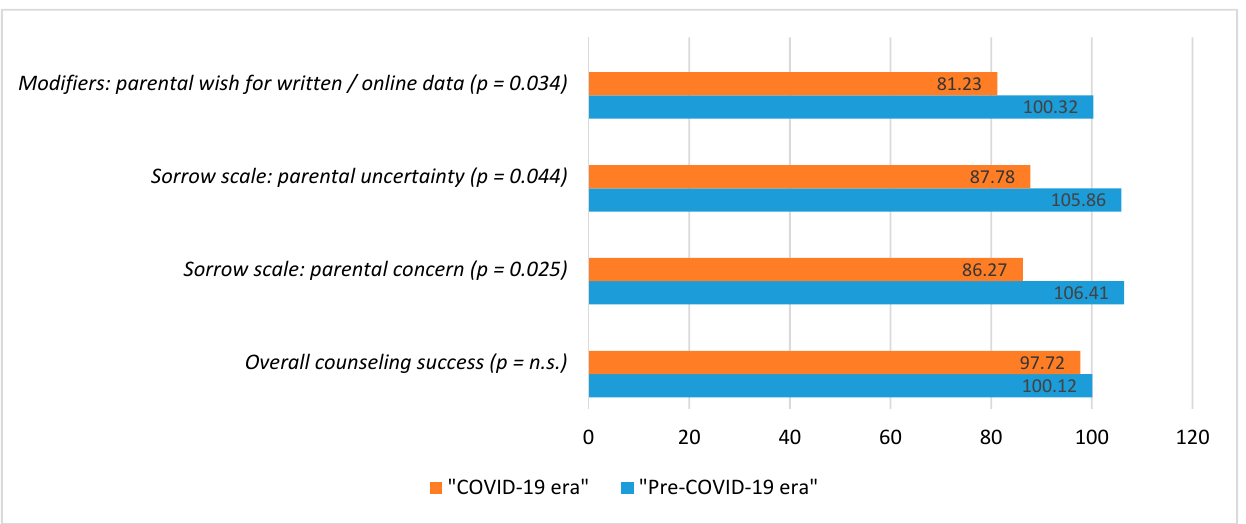
Figure 1. Distribution of counseling success (1. successful, 2. satisfying, 3. unsuccessful) for “paren- tal perceived situational control” with regard to parental native language (i.e., parental native lan- guage differing from the language counseling was conducted in).